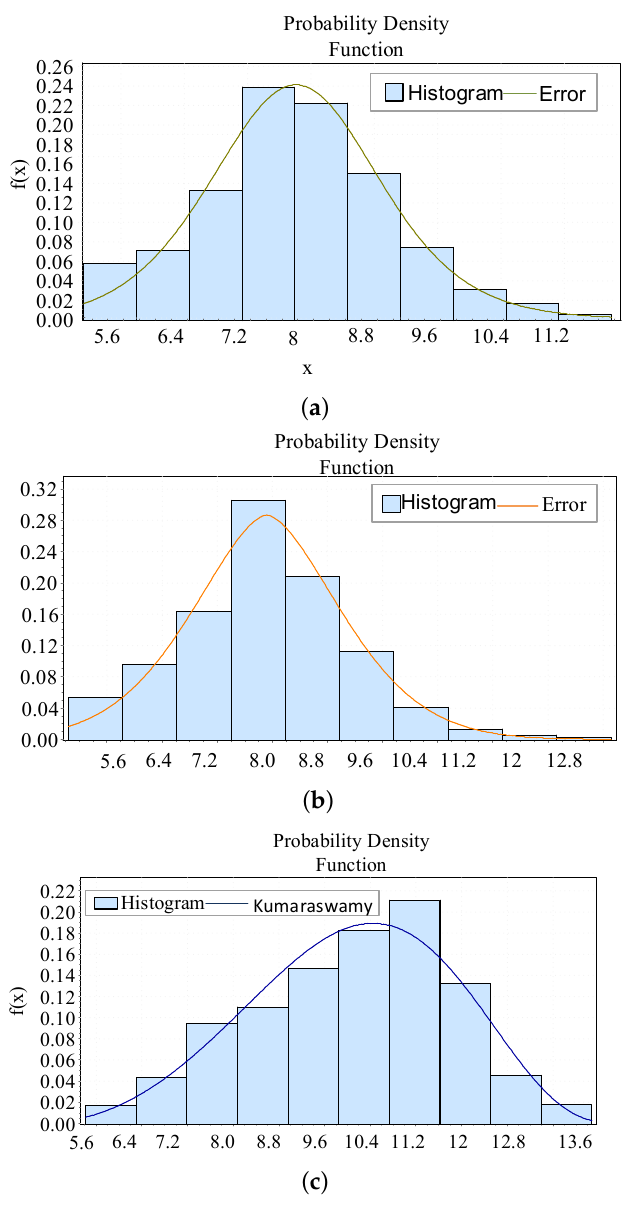
Figure 7. The distribution of the PPD in each scheme. ( a ) The average value of the PPD in Scheme A. ( b ) The average value of the PPD in Scheme B. ( c ) The average value of the PPD in Scheme